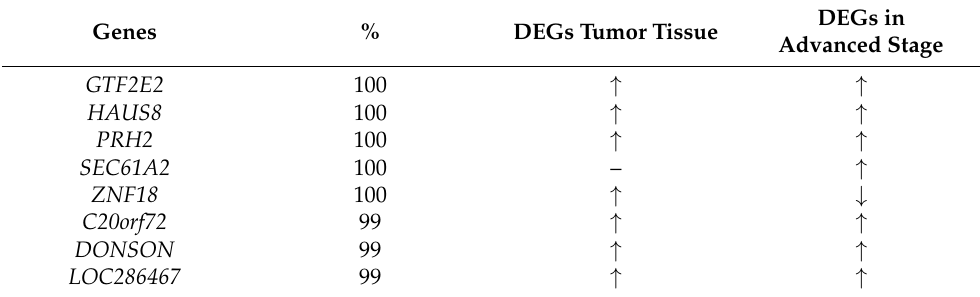
Table 6. List of the 20 most selected genes by TCox when α = 0.1. Arrows represent if genes are upregulated ( ↑ ) or downregulated ( ↓ ) in tumor tissue or the advanced stage of the disease and % is the percentage of the runs where a certain gene appears in the solution. – genes that are not differentially expressed in tumor